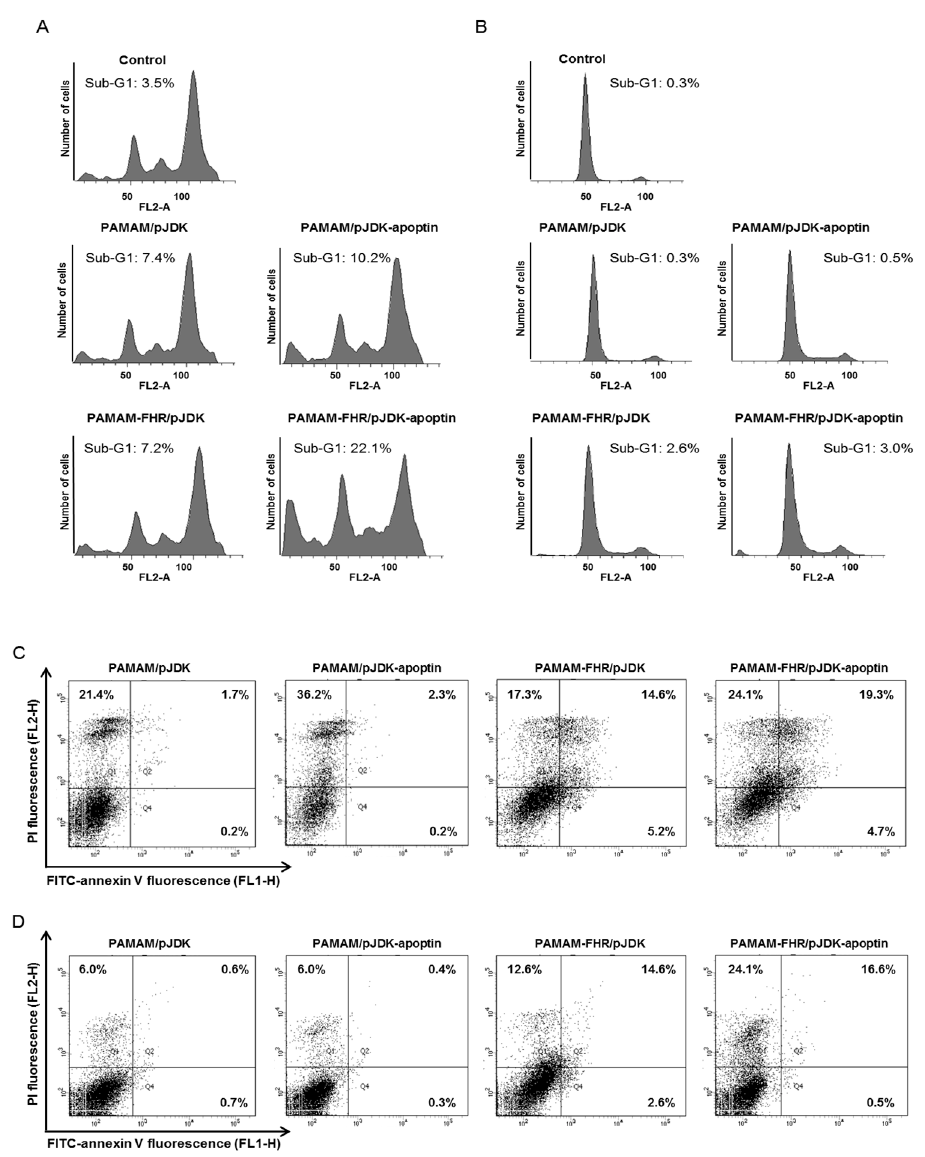
Figure 8. Apoptosis of the PAMAM-FHR/pJDK-apoptin. ( A , B ) Cell cycle phase of